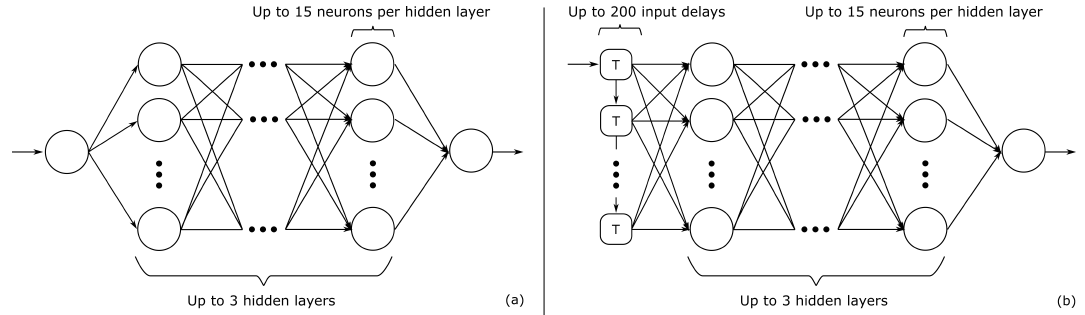
Figure 4. Neural network regression model configurations used throughout this work: ( a ) multi-layer perceptrons. ( b ) time-delay neural networks.